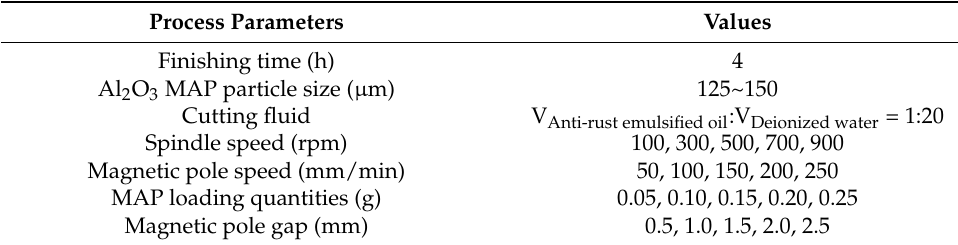
Table 5. Experimental parameters.